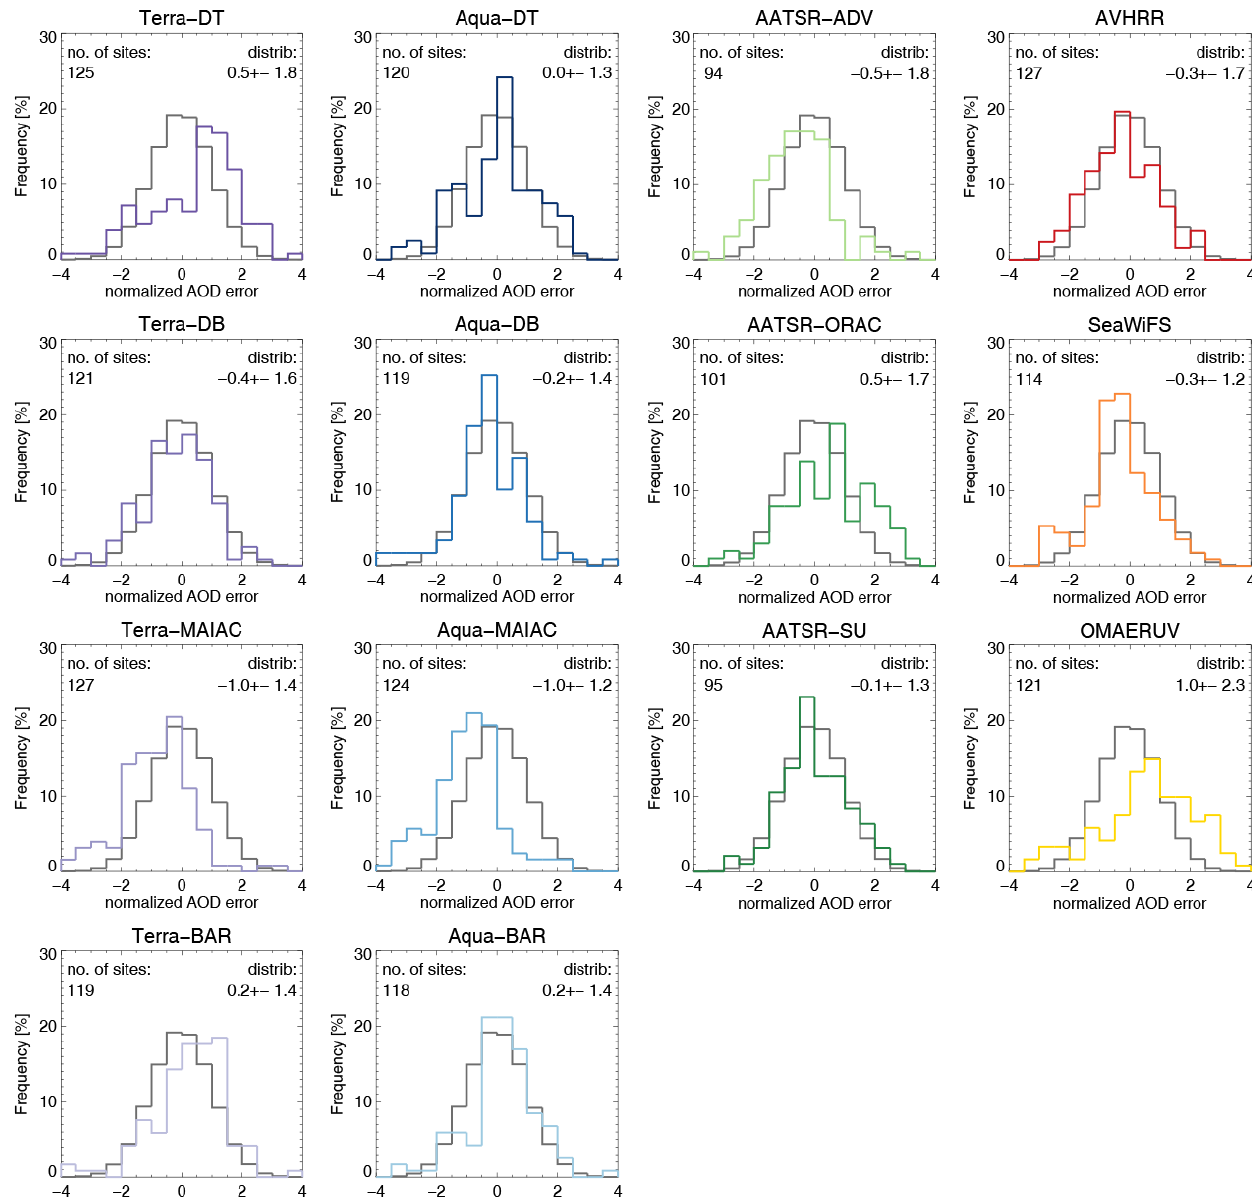
Figure 23. The 3-year averaged AOD error distributions, normalized to the diversity (spread in the ensemble; see Fig. 21). Errors are based on individual collocations of products with AERONET (within 1h), unlike the diversity which is based on collocation of either all morning or afternoon satellite products together. Mean and standard deviation of the product’s distribution are shown in the upper left corner. Only sites with at least 32 observations were used. For comparison, a normal distribution with mean zero and standard deviation of 1 is also shown (in